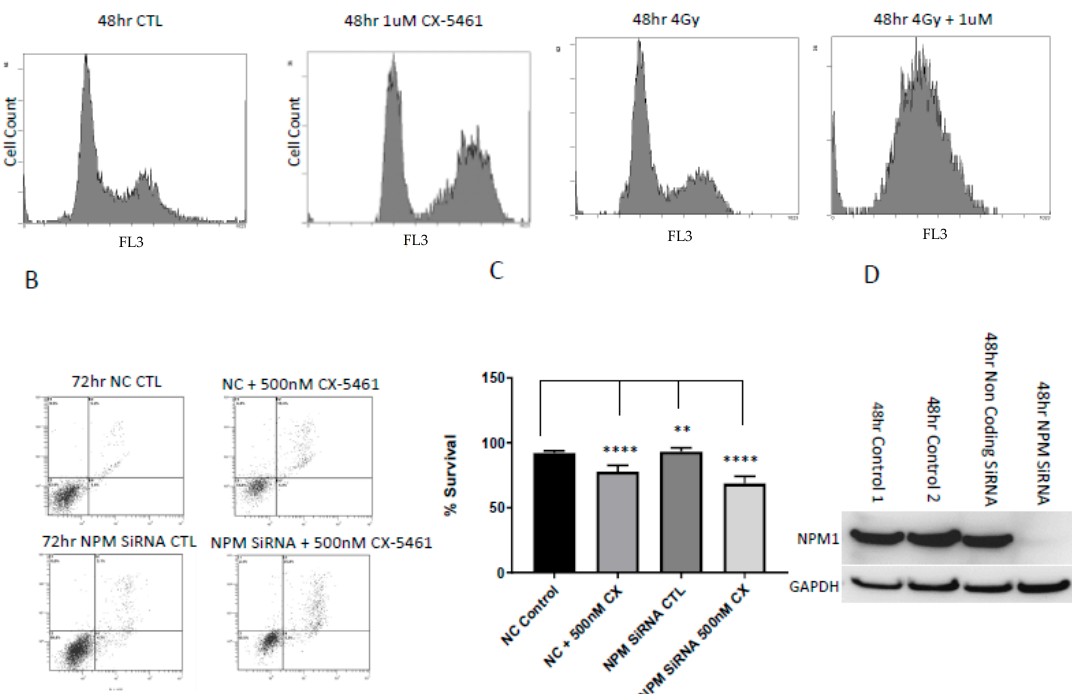
Figure 8. Cell cycle analysis of CaSki cells exposed to CX-5461 alone, radiation alone and in combination for 48 h showed that treatment with CX-5461 alone for 48 h induced strong G2/M arrest compared to radiation-alone treatment, combined treatment resulted in the abolition of the cell cycle, as shown by propidium iodide staining using flow cytometry ( A ). (48 h CaSki control cell cycle values: G0-6%, G1-51%, S-15% G2M-28%. The 1 µM CX-5461 cell cycle values: G0-3%, G1-41%, S-6%, G2M-49%. 4 Gy-radiation-alone cell cycle values: G0-0.8%, G1-53.2%, S-9.2%, G2M-29.4%. Combined 1 µM CX-5461 and 4 Gy X-rays resulted in complete abolition of G2M blockade). NPM1 silenced cells are more sensitive to RNA Pol I inhibition. ( B , C ) Flow cytometry (annexin assay) showed that NPM1 silenced cells were found to be more sensitive towards CX-5461 treatment compared to non-coding treated CaSki cells ( p -value < 0.0001). CaSki cells were transiently silenced for nucleophosmin (NPM1). Knock down was confirmed through Western blot analysis ( D ). ** = p value < 0.01 and **** = p value < 0.0001.